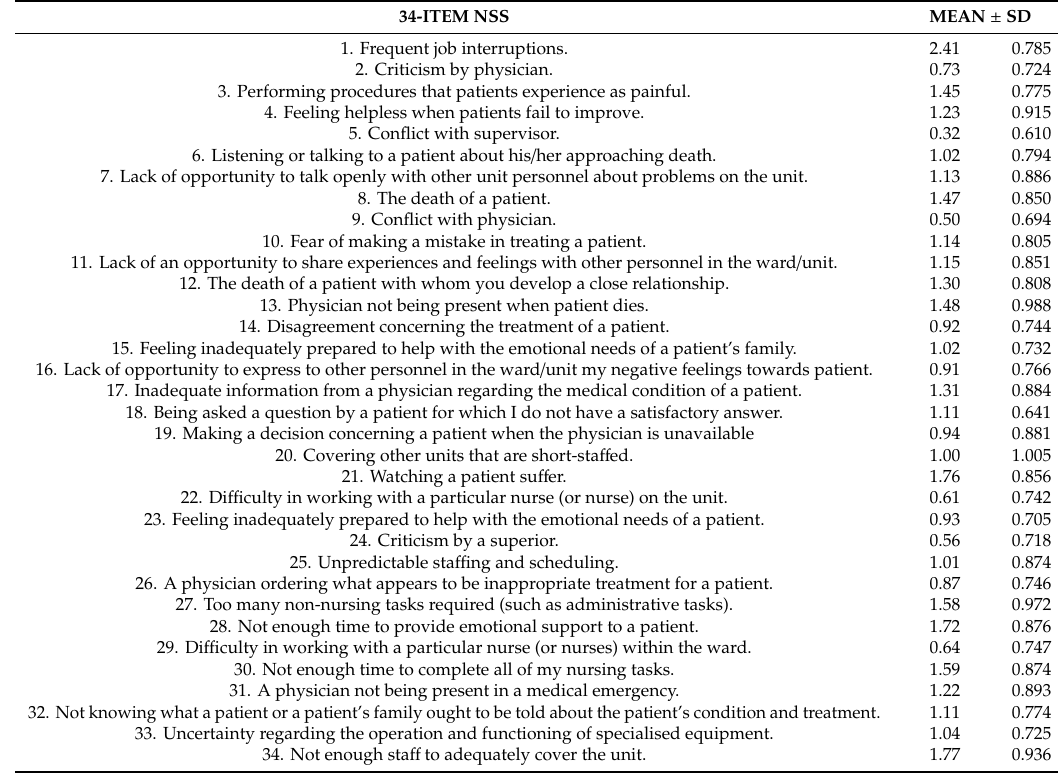
Table 2. Description of 34-item Nursing Stress Scale